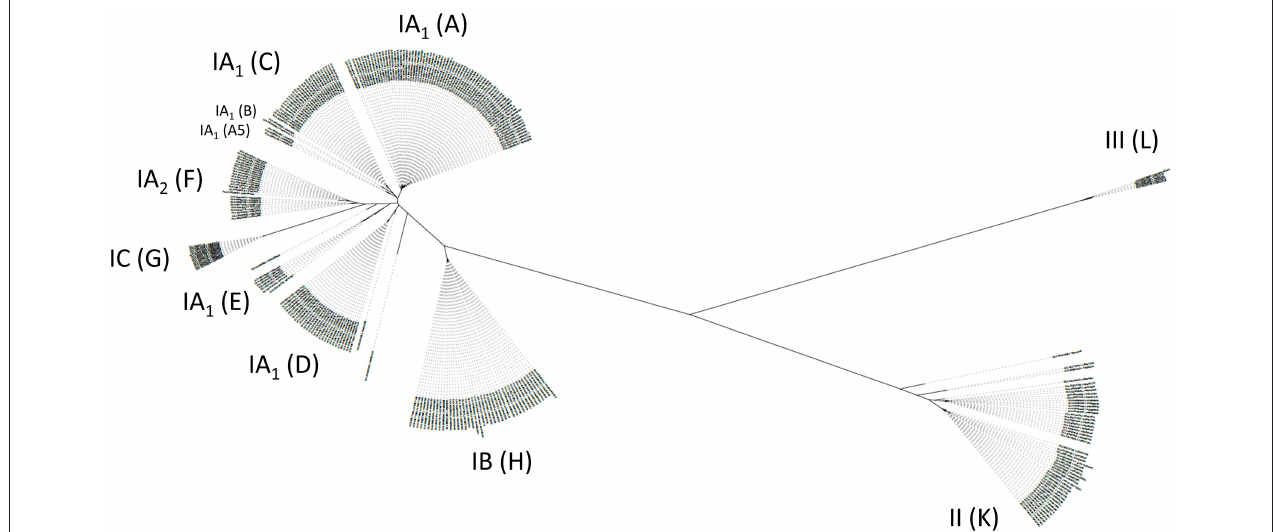
FIGURE 2 | Diversity of the population of C. acnes. A population tree is shown based on a phylogenomic comparison relying on core genome-located nucleotide polymorphisms. Distinct phylotypes of C. acnes are highlighted as six main phylotypes IA 1 , IA 2 , IB, IC, II, III, and 10 SLST types A-L. SLST types F, G, H, K, L correspond to phylotypes IA 2 , IC, IB, II, and III, respectively. Please note that SLST types A–E are distinct clades of phylotype IA 1 . In particular, SLST types D and E are distinct from acne-associated SLST types A–C. In total, 286 publicly available C. acnes genomes were analyzed and the closed genome of strain KPA171202 (phylotype IB, SLST type H) was taken as reference [modified from Brüggemann